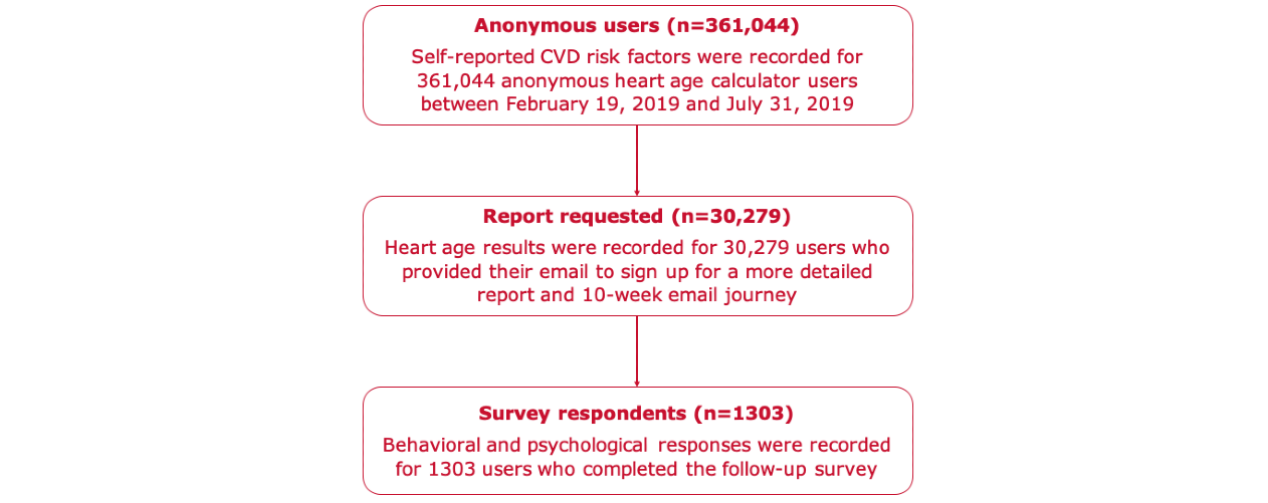
Figure 4. Sample flowchart.